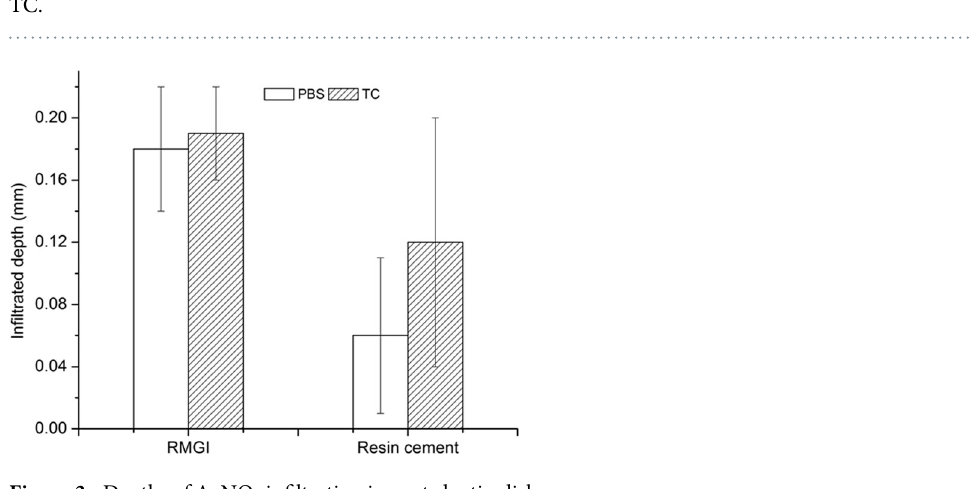
Figure 3. Depths of AgNO 3 infiltration in post-dentin